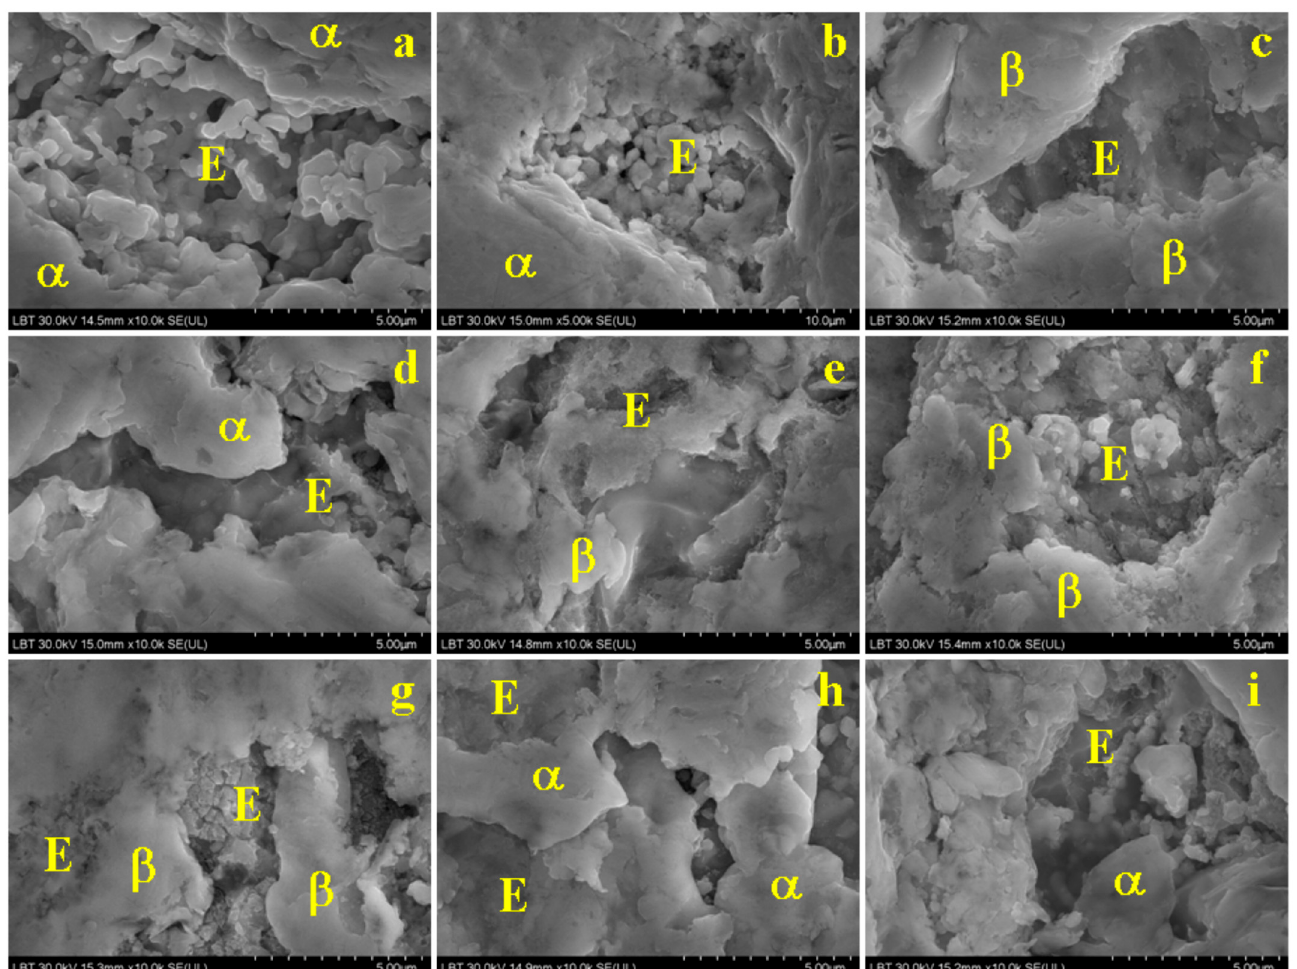
Figure 7. SEMmorphologic details revealed on the surface of investigated 3-Polker coins issued in: ( a ) 1619, ( b ) 1620, ( c ) 1621, ( d ) 1622, ( e ) 1623, ( f ) 1624, ( g ) 1625, ( h ) 1626, and ( i ) 1627, where E— eutectic, α —silver phase, and β —copper phase. Figure 8. The border line between good and depreciated coins is on the title of 80% Ag. It is clear from the results that the coins issued in 1619, 1620, 1626, and 1627 are made of good silver.